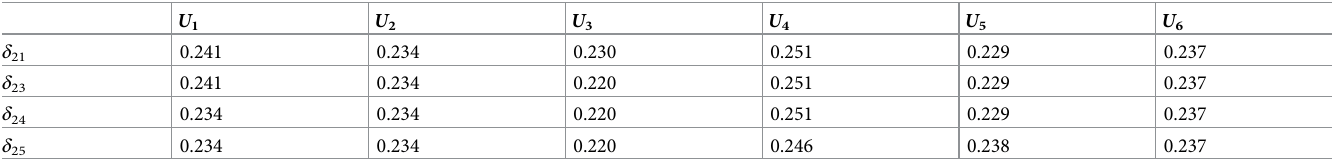
Table 10. The transformed probability of alternative O 2 to others.